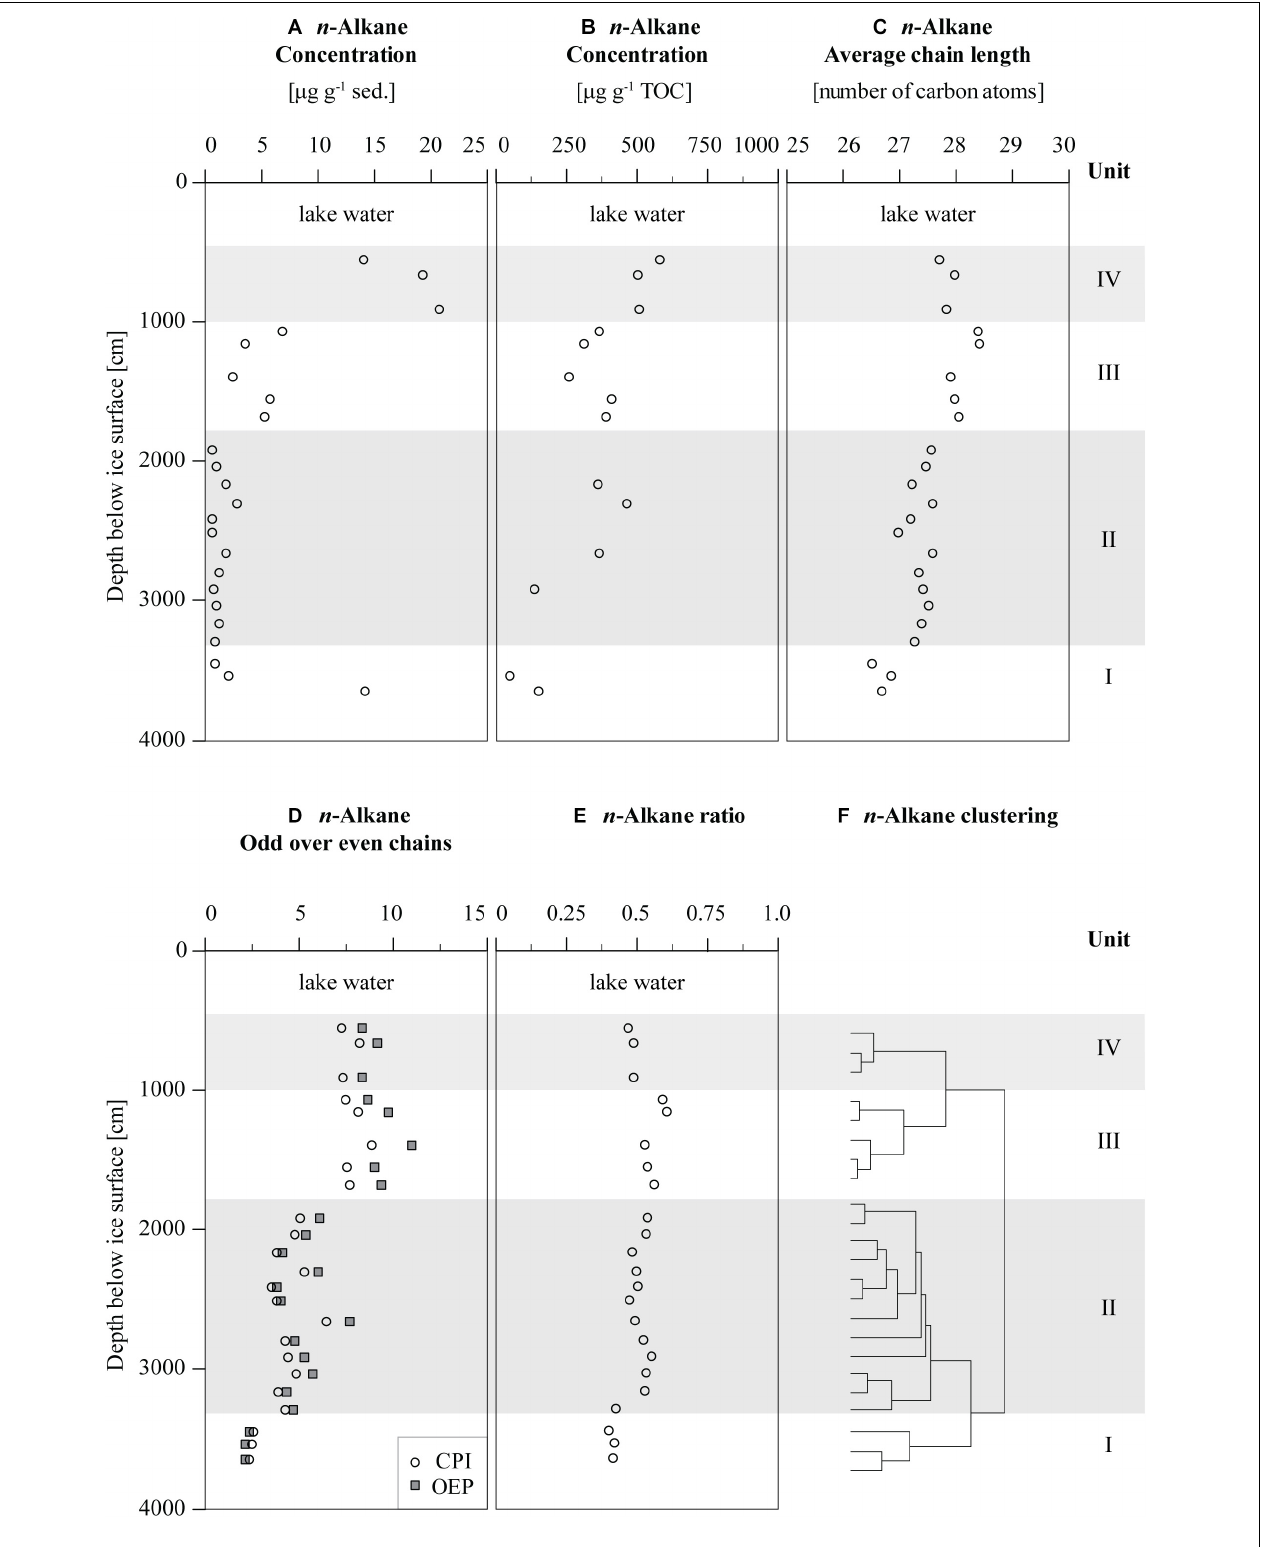
FIGURE 5 | n -Alkane parameters of Goltsovoye Lake sediment core PG2412. (A) n -Alkane concentration per gram sediment, (B) n -alkane concentration per gram organic carbon (note: samples with TOC < 0.1 wt% not shown), (C) n -alkane average chain length, (D) n -alkane carbon preference index (CPI) and odd-over-even predominance (OEP; gray squares), (E) n -alkane ratio (after Schäfer et al., 2016), and (F) n -alkane clustering. Units indicated on the right.